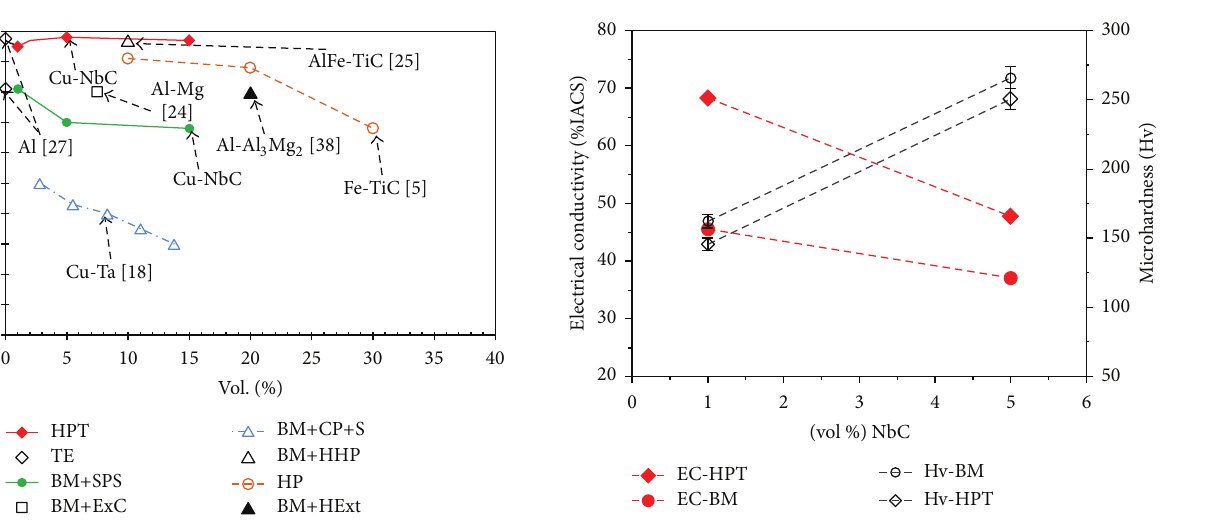
Figure 4: Density of different composites and alloys fabricated by different techniques and consolidation methods. HPT: high pressure torsion, BM+SPS: ball milling followed by spark plasma sintering, BM+CP+S: ball milling followed by cold compaction and sintering, HP: hot pressing, TE: torsion extrusion, BM+ExC: ball milling followed by explosive consolidation, BM+HHP: ball milling followed by high pressure hot pressing, and BM+HExt: ball milling followed by hot extrusion.